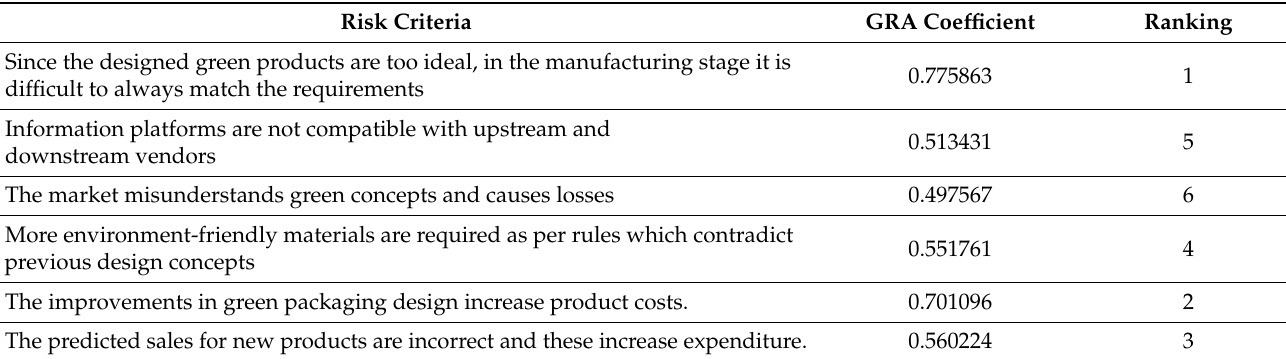
Table 5. The ranking of the green criteria in the green